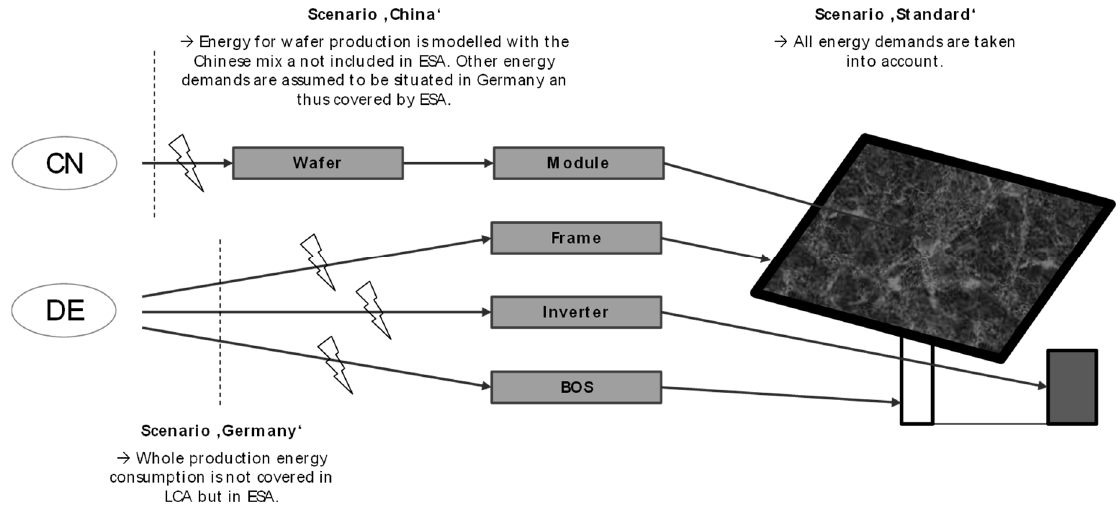
Figure 5. Schematic flow chart of the adjustment of LCA models in the use case for the adoption to ESA. The scenario Standard includes all energy inputs along the life cycle. The production groups include the module, frame, inverter and balance-of-system (BOS).